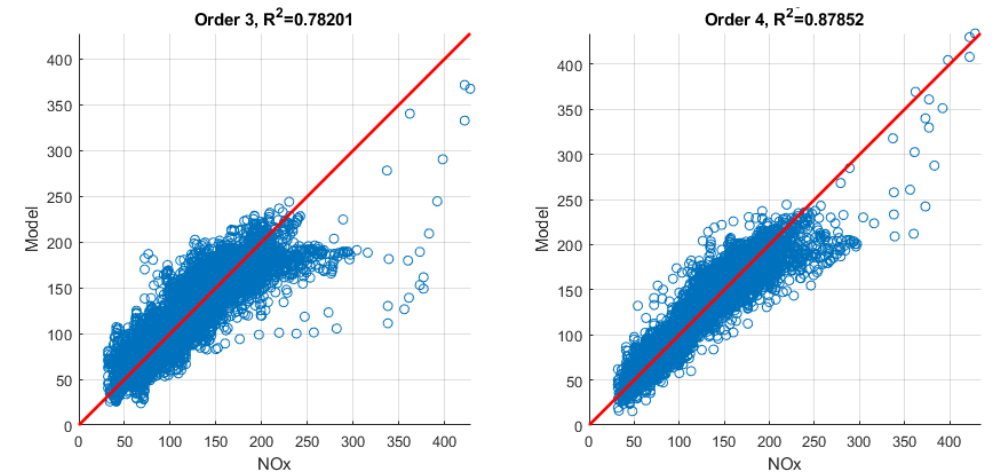
Figure 10. Correlation of predicted and original data for selected 10